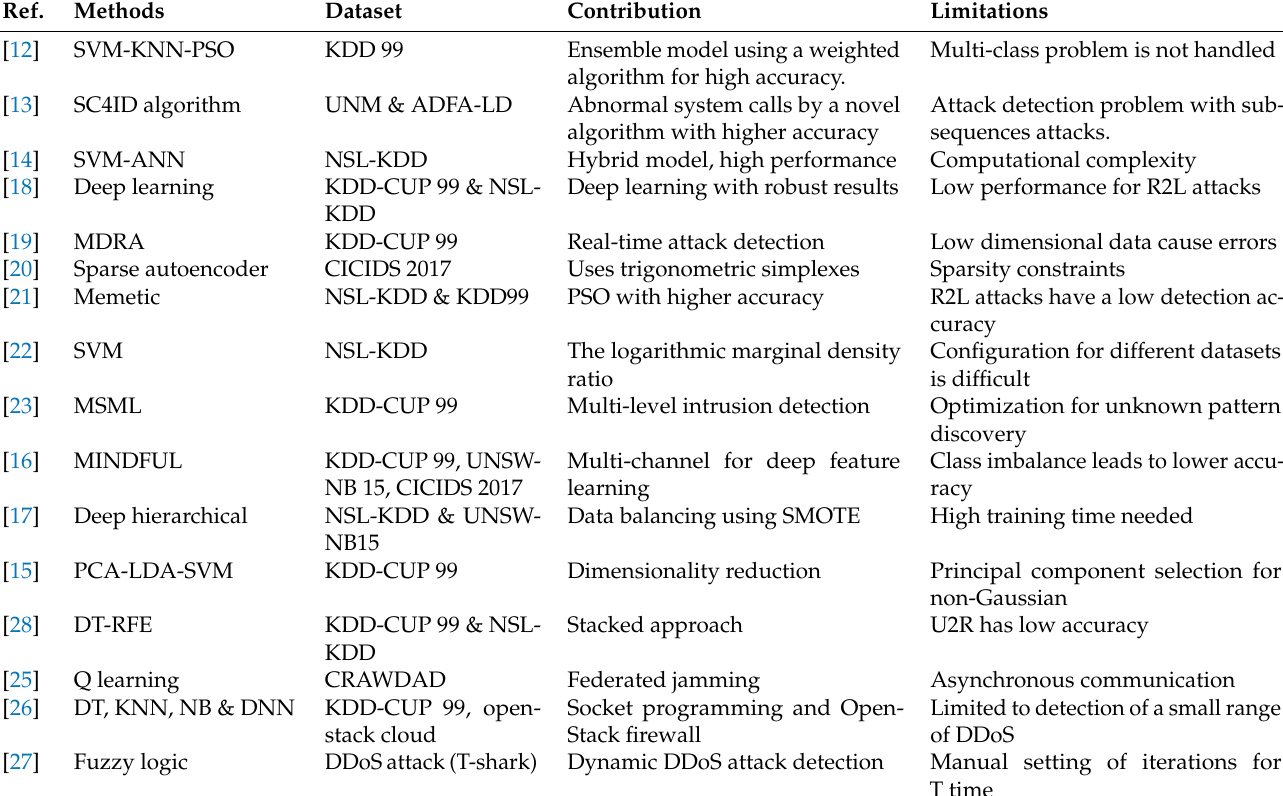
Table 1. Comparative analysis of the existing